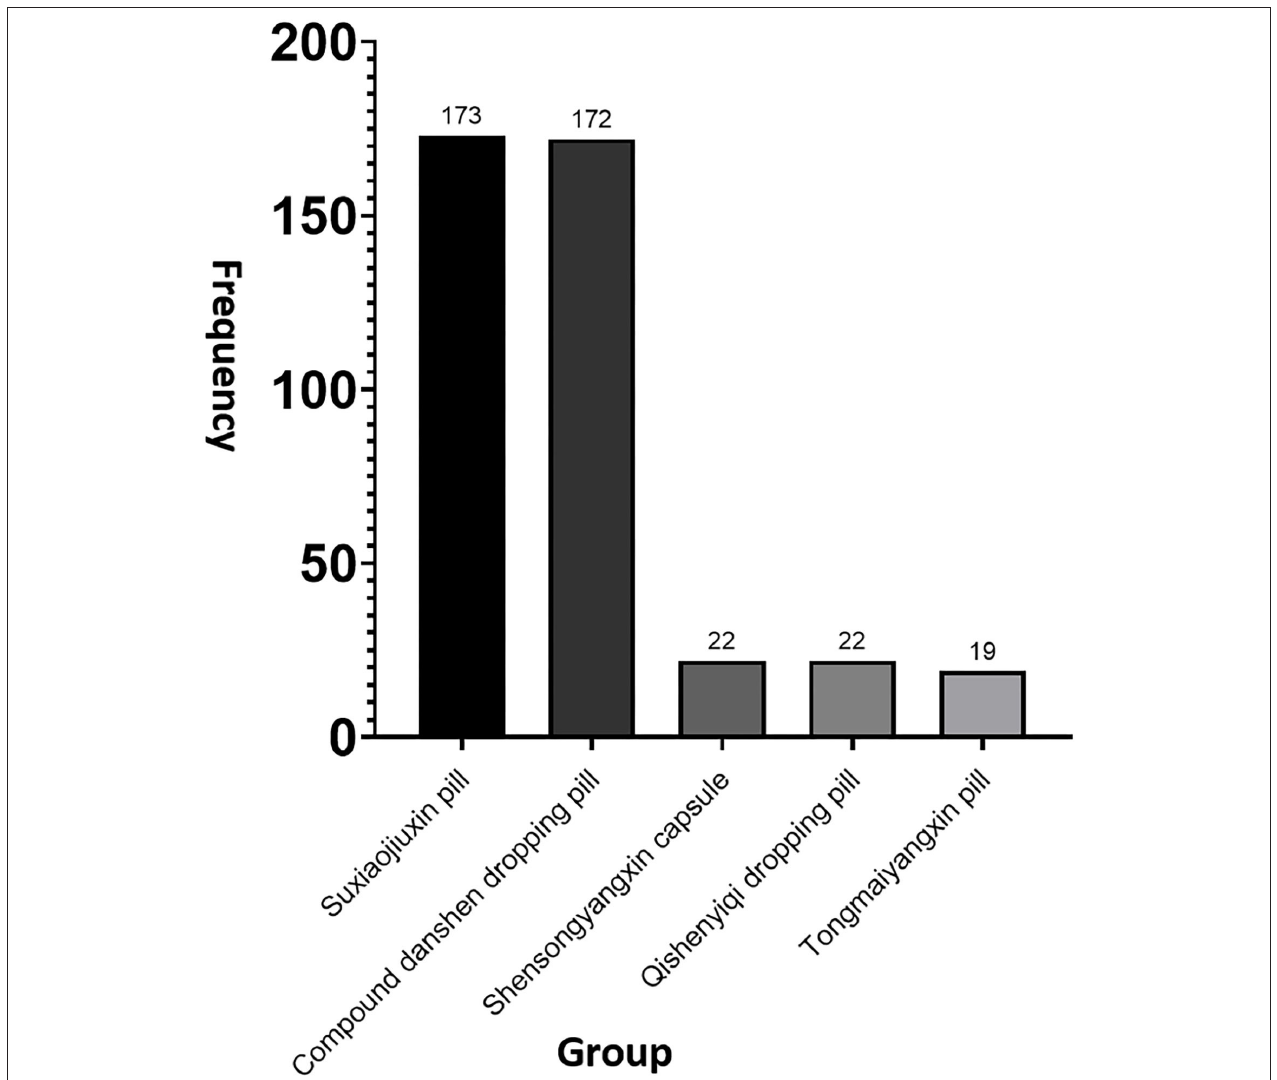
FIGURE 3 | The top five used the TCM in cohort study. Totally, there were 173 patients using Suxiaojiuxin pill, 172 patients using compound Danshen dropping pill, 22 patients using Shensongyangxin capsule and Qishen Yiqi dropping pill, and 19 patients using Tongmai Yangxin